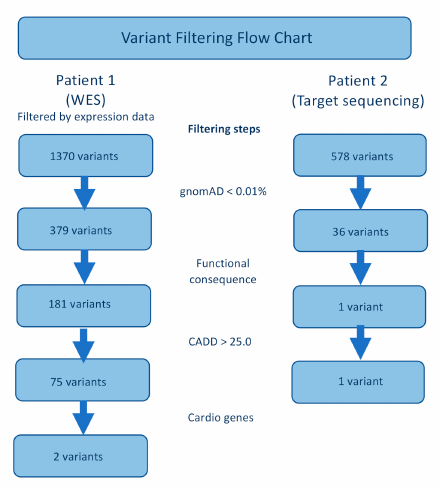
Figure 1. Genotyping flowchart for Patients 1 and